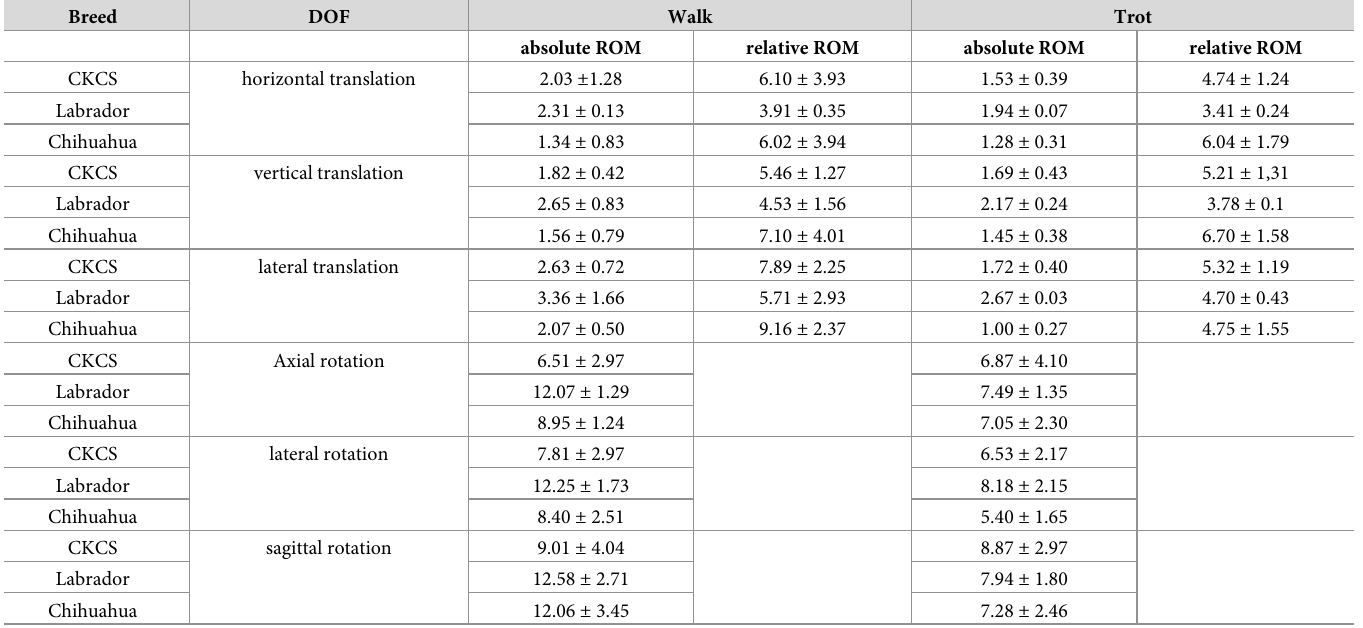
Means and standard deviations averaged for all CKCSs, Labrador retrievers and Chihuahuas in walk and trot. Absolute range of motion indicates the measured range of motion in cm or ˚, relative range of motion for the translations indicates the absolute range of motion related to the wither height of the dogs in % [(absolute ROM in cm/ wither height in cm) x